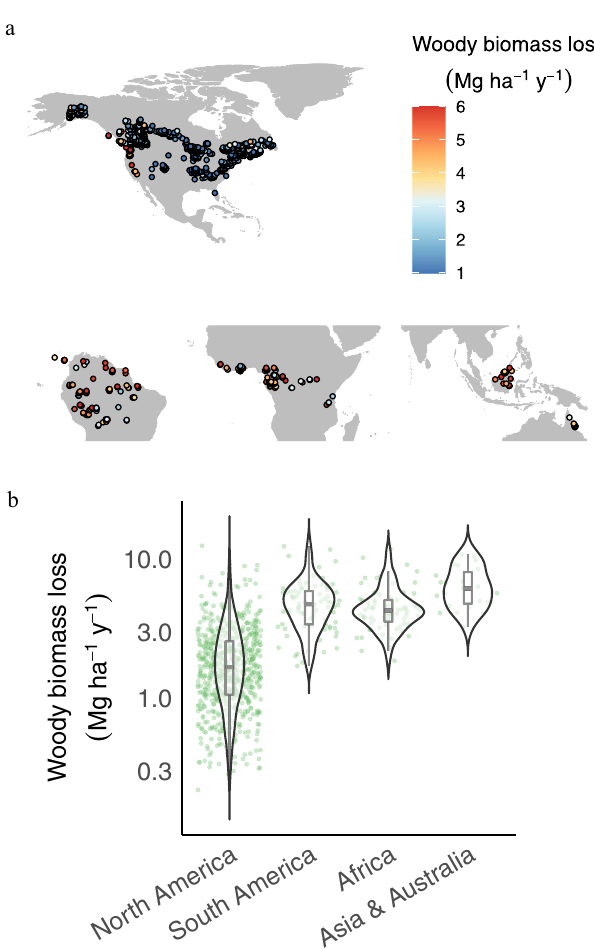
Fig. 1 Map of sample locations and biomass loss to mortality (LOSS) data. a Sampling sites. A total of 2676 samples were collected and aggregated into 814 grids at 0.25 degree that were used for geospatial modeling. b The median and interquartile range of LOSS across continents — North America, South America, Africa, and Asia &